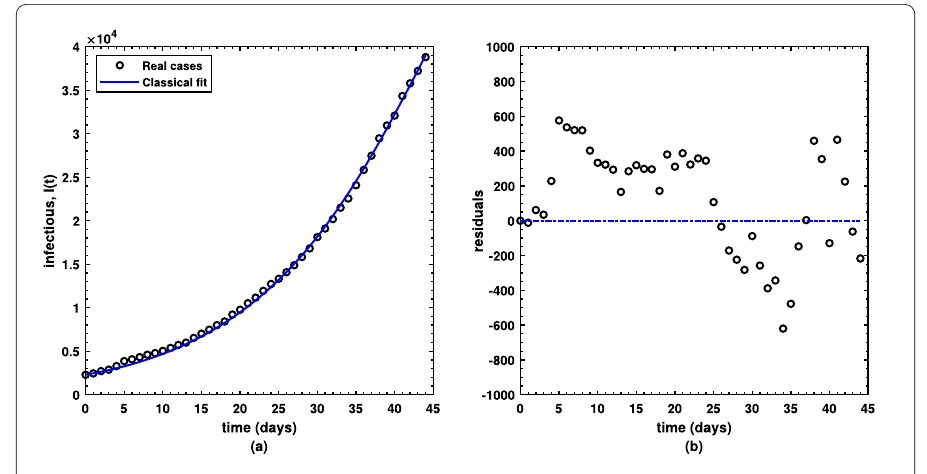
Figure 1 ( a ) Best data fitting for COVID-19 daily cases (black circles) in Pakistan from 1 April to 15 May 2020 with the infectious class I ( t ) (solid blue line) of the model under the classical case ( ν = 1) and the ( b ) respective residuals